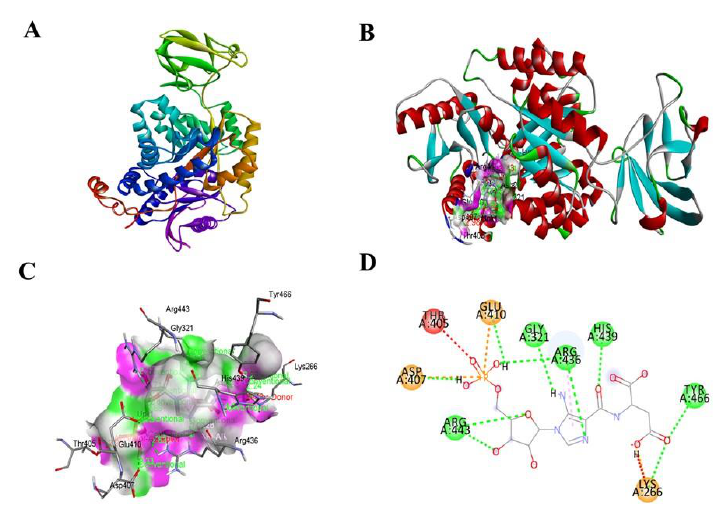
Figure 2. An oncometabolite SAICAR (CHEBI ID: 18319) shows strong molecular binding with pyruvate kinase M2 (PKM2) enzyme (PDB ID: 4G1N). Molecular docking and interaction of SAICAR with PKM2 were visualized with the help of Discovery Studio Visualizer. ( A ) Molecular docking affinity estimated by AutoDock Vina. ( B ) Three-dimensional view of interaction between SAICAR and PKM2 with binding residues, bond distances, and types of bonds. ( C ) The docked molecular structure between SAICAR and PKM2 is visualized in a 3D image depicting H-bond interactions (acceptor in green and donor in pink color) ( D ) Two-dimensional image of docked molecular structure between SAICAR and PKM2 derived from Discovery Studio Visualizer.